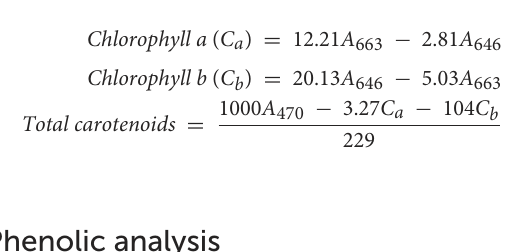
chlorophyll A, chlorophyll B, and total carotenoids as